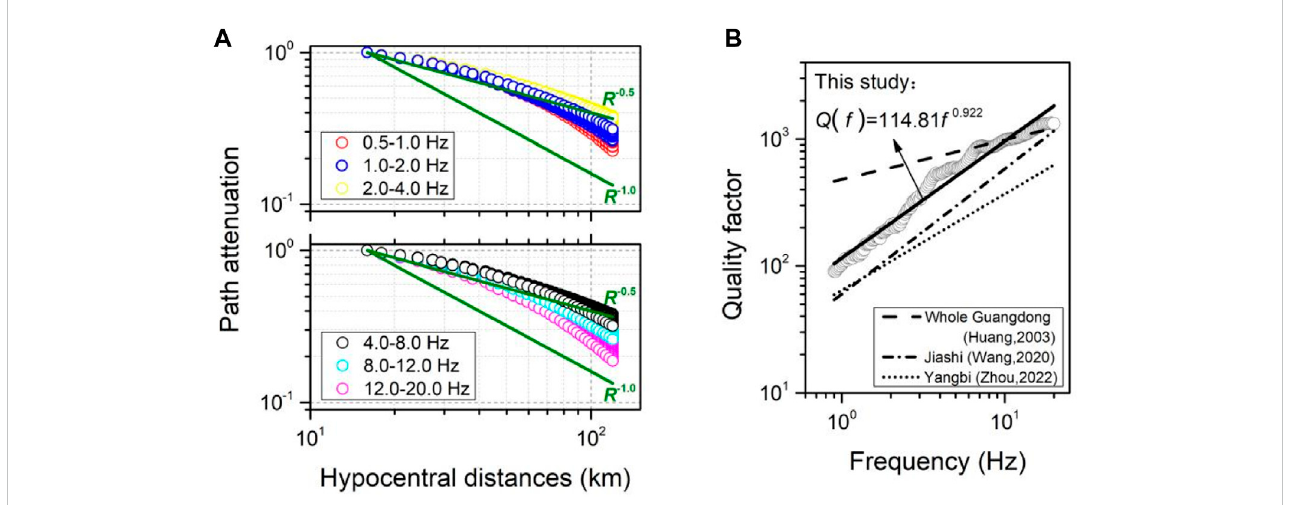
FIGURE 7 (A) .5 – 20 Hz path attenuation in eastern Guangdong. (B) .9 – 20.0 Hz frequency-dependent quality factor Q . Solid line represents the least squares regression curve, which is 114.81 f .922 . The dashed line, dash-dotted line and dotted line indicate the quality factors of whole Guangdong province, Jiashi and Yangbi,